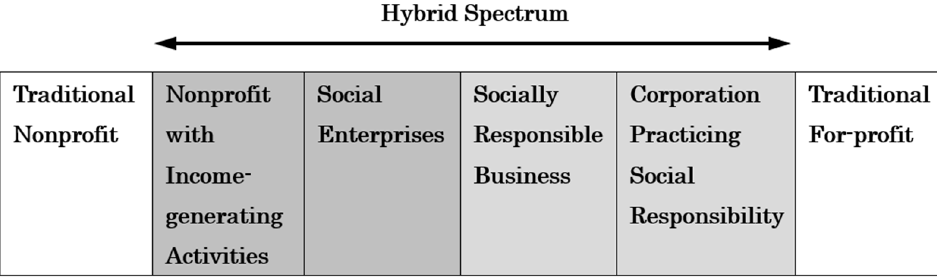
Figure 3. Hybrid spectrum. Source: Alter (2006).